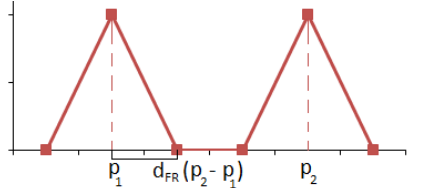
Figure 6: Bi-triangular output distribution induced by Fuzzy Re- combination operator.